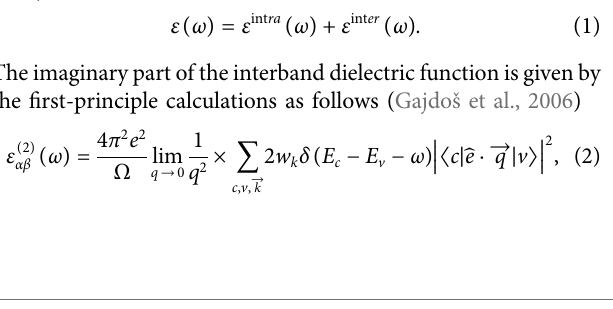
Frontiers in Chemistry |